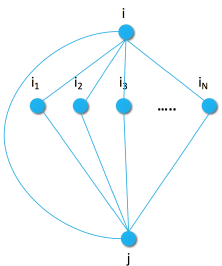
Figure 2. Pairwise similarity graph with sample set S = { i 1 , i 2 ,..., i N } for a pair of items i and j